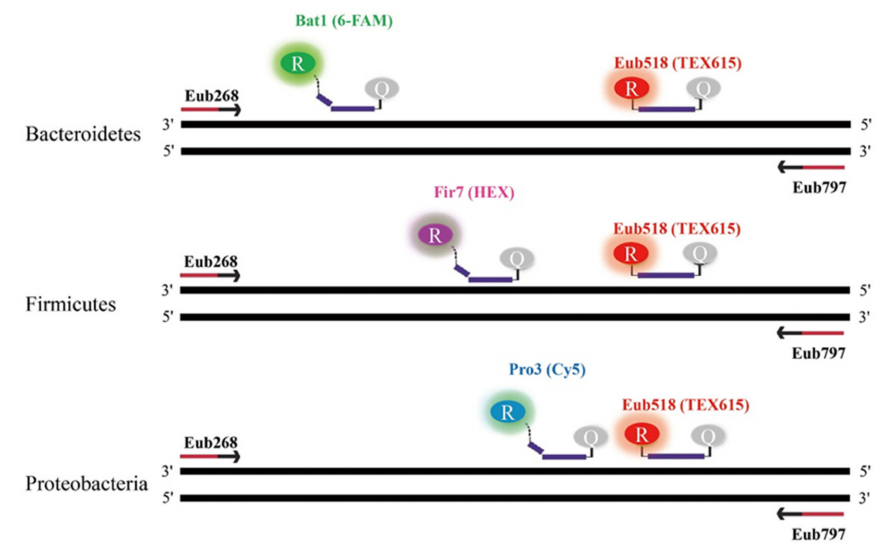
Figure 6. Schematic view of the multiplex TaqMan qPCR for simultaneous detection of the three dominant phyla in gut microflora (Bacteroidetes, Firmicutes, and Proteobacteria) in one PCR